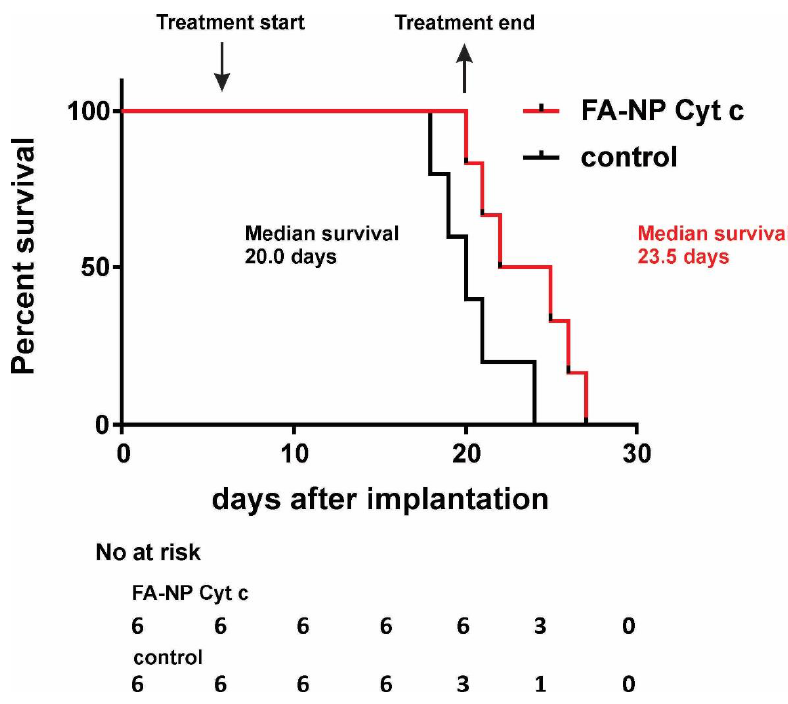
Figure 6. Local in-tumor infusion of FA-Cyt c NPs increases the survival rates in GL261/C57Bl/6 mouse glioma model. FA-Cyt c NPs (100 mg/mL diluted in PBS) were infused to the tumor at rate of 1 μL/h over 14 days, beginning on the 7th day after the tumor implantation, through mini-osmotic pumps. Control animals received PBS only. Kaplan-Meier survival analysis is shown. six animals per group were used. Curve comparison was performed with use of log-rank (Mantel-Cox) test ( p < 0.05).